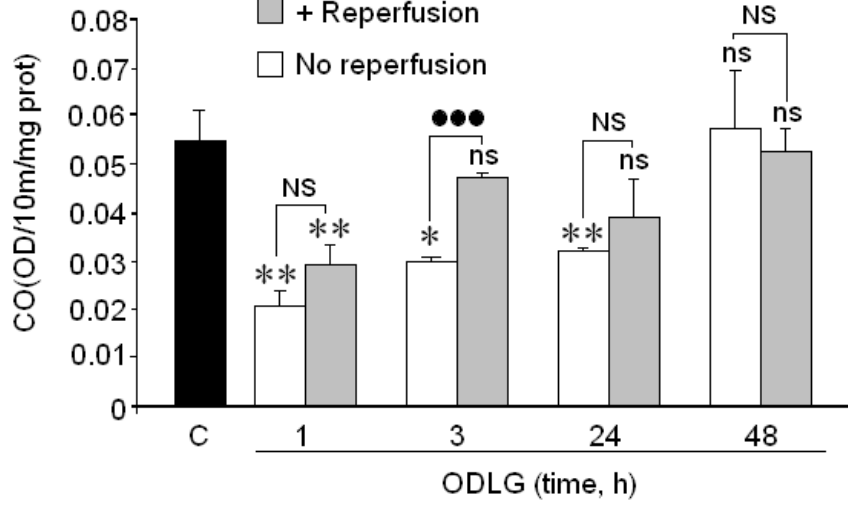
Figure 5. Effect of 1 to 48 h of ODLG on cytochrome oxidase activity. Results are means ± SEM in two experiments with cells from different cultures, each one performed in triplicate with different batches of cells (6 measurements/condition). ns = not significant ( vs. control); NS = no significant ( vs. ischemia with or without reperfusion); (*) = p < 0.05 ( vs. control); (**) = p <0.01 ( vs. control); ( ••• ) = p < 0.005 ( vs. ischemia with or without reperfusion).